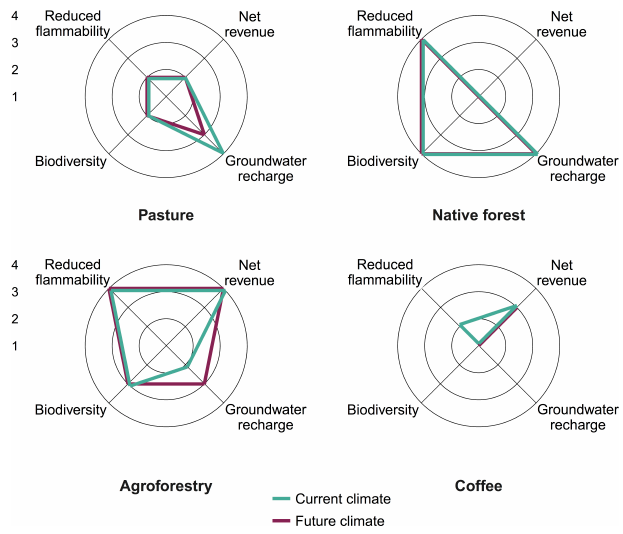
Fig. 6. Synergies and trade-offs in outcomes across land-use scenarios for net revenue, water, fire, and biodiversity). Axis values indicate the land-use scenario rank (among pasture, nature forest restoration, agroforestry, and coffee), with 4 indicating the greatest benefit and 1 the lowest benefit. Cultural ecosystem services and values tied to each scenario are outlined in detail in Table